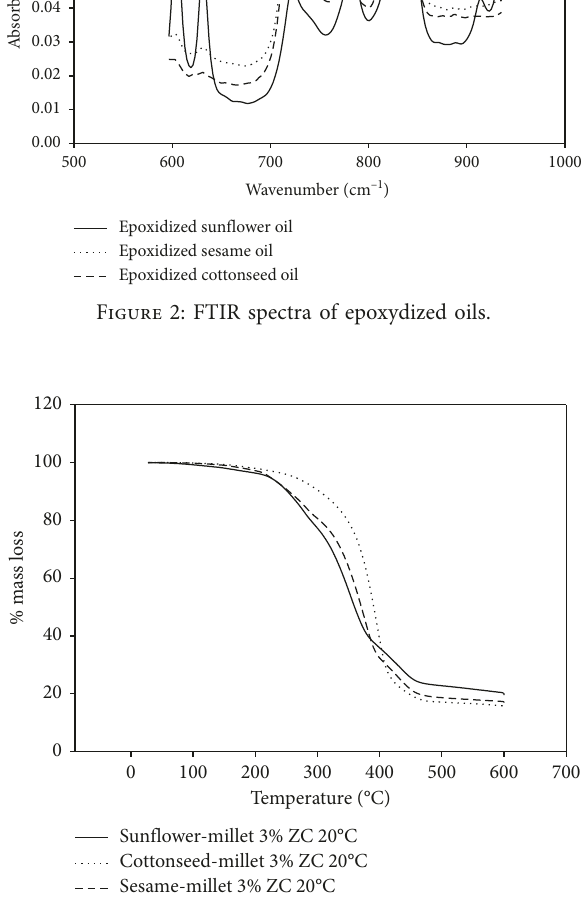
Figure 3: Epoxy resin TGA thermograms of sunflower, cottonseed, and sesame oil blended with millet flower and 3% zinc